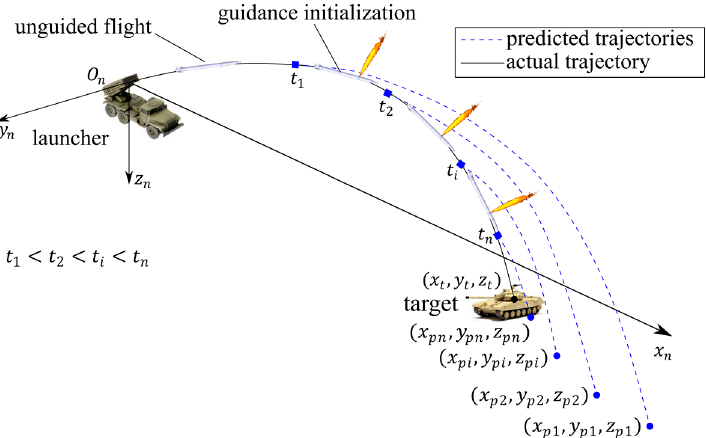
Figure 3. The concept of predictive